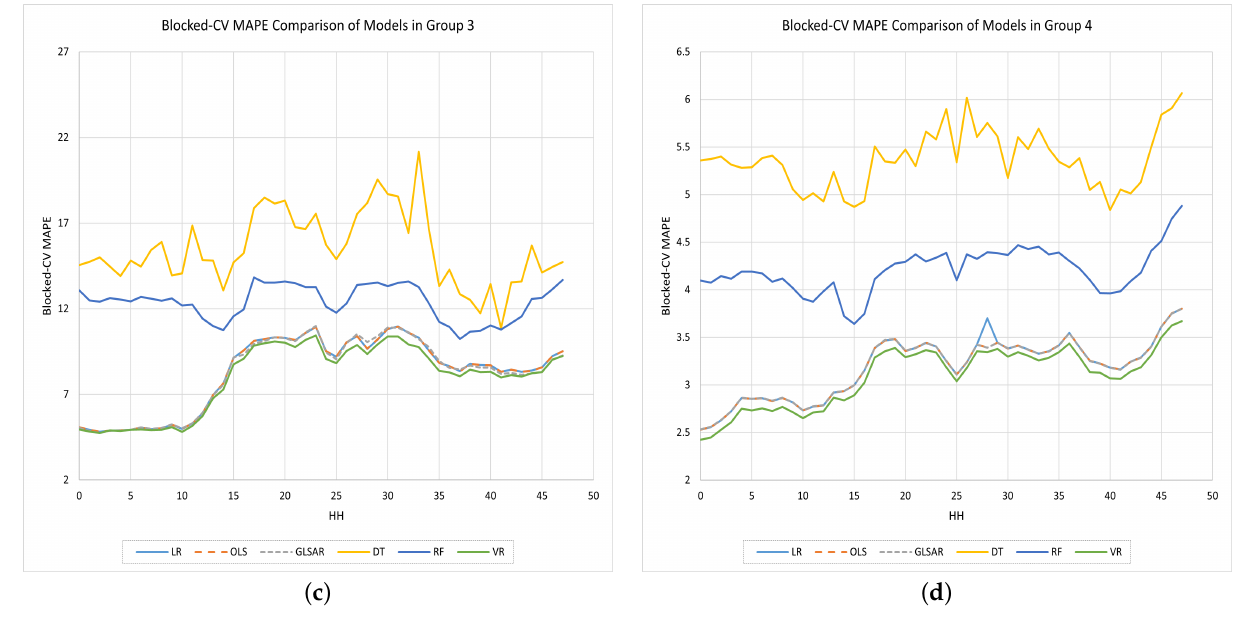
Figure 6. Comparison of the Blocked-CV MAPE values obtained by each half-hourly model in each group; ( a ) Group 1. ( b ) Group 2. ( c ) Group 3. ( d ) Group 4. The errors of DT and RF models are comparatively higher than those of the other models for each half-hour in each group, and they are worse during off-peak times. The use of MSE instead of MAPE to measure the quality of the split in default for these two nonparametric models could be one reason for this. The other three parametric models always produced lower error values than DT and RF. Overall, the results suggest that the VR model (green color curve) in each group excels in predicting with lower values for both E v E test . , Blocked − CV and